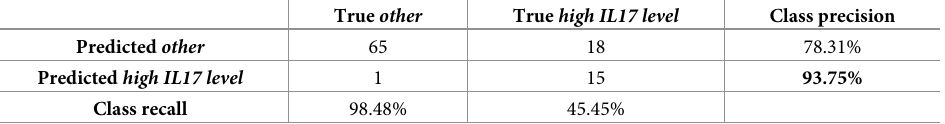
Table 3. Performance parameters of classification model targeting binary labeling high IL17 level vs. other . Accu- racy 80.89%